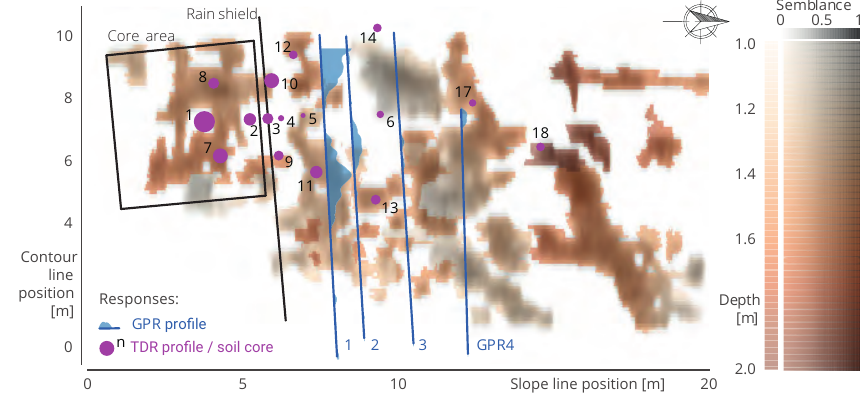
Figure 10. Potential subsurface structures from 3-D GPR survey and setup of hillslope experiment. Structure identification guided by the dip corrected semblance attribute. Depth estimated based on mean measured effective radar velocity in soil of 0.07mns − 1 . Summary of the hillslope experiment given by locations of TDR profile tubes (purple, also location of respective soil cores in Fig. 5) and GPR transects (blue). Dot size of TDR scaled to maximum of observed change in soil moisture. Along GPR transects lateral marginals of the structural similarity attribute as proxy for recorded advection. Note that the picked potential subsurface structures are located in different depth (white to black) and that variations in spatial contrast can be seen in the semblance attribute (white to orange). Where more than one horizon has been identified the top one is